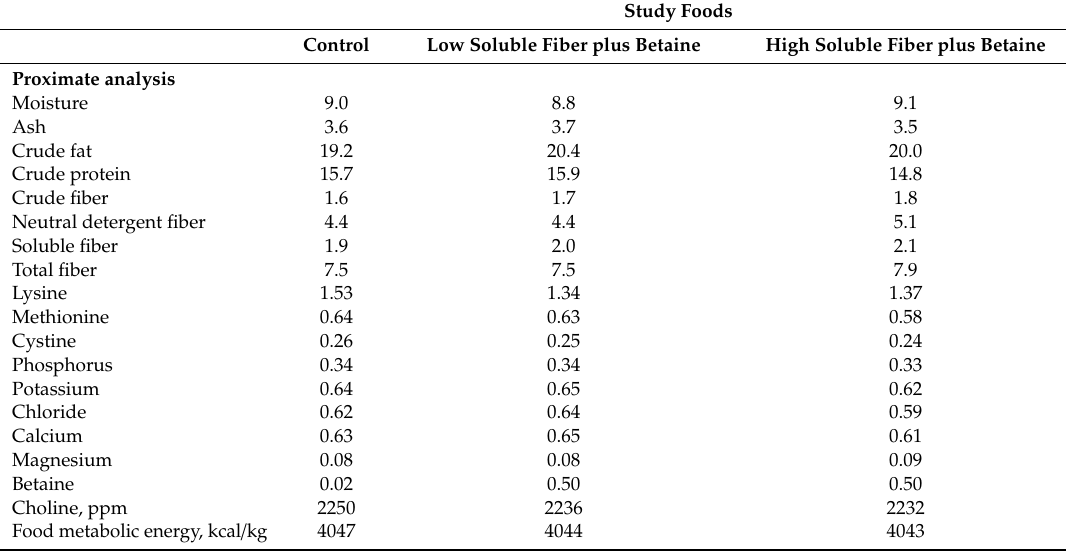
Table 1. Proximate analysis of the three study foods.